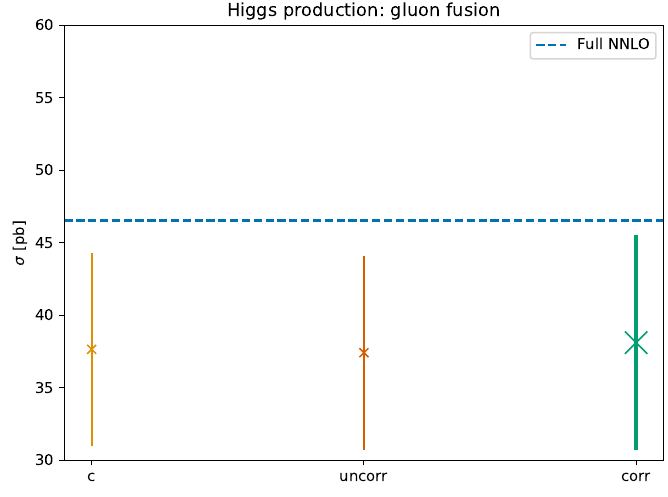
Figure 9 . NLO total cross sections for the Higgs production cross section by gluon fusion at NLO √ for s = 13 TeV. The uncertainty on each result is the total theoretical uncertainty, which includes both PDF and scale uncertainties according to the three different prescriptions described in the text and in table 3. The NNLO result, which uses the NNLO NNPDF3.1 baseline PDFs, is also